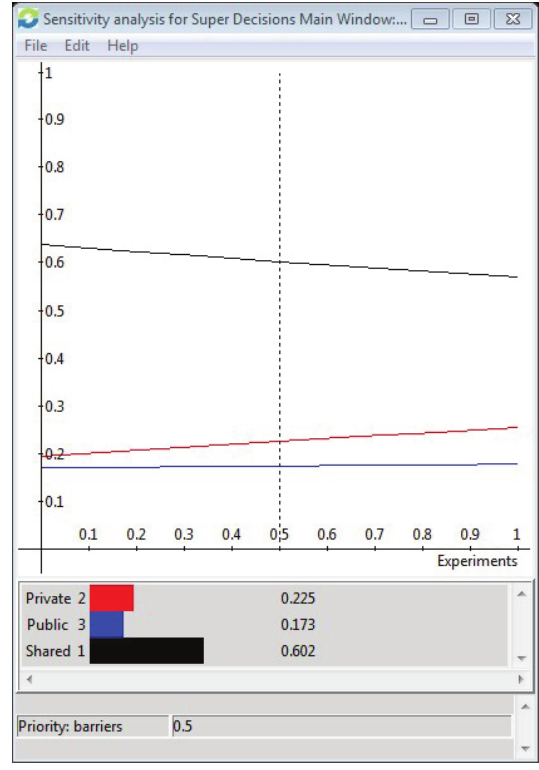
Figure 3. Sensitivity analysis for uncertain tariff reviews risk based on